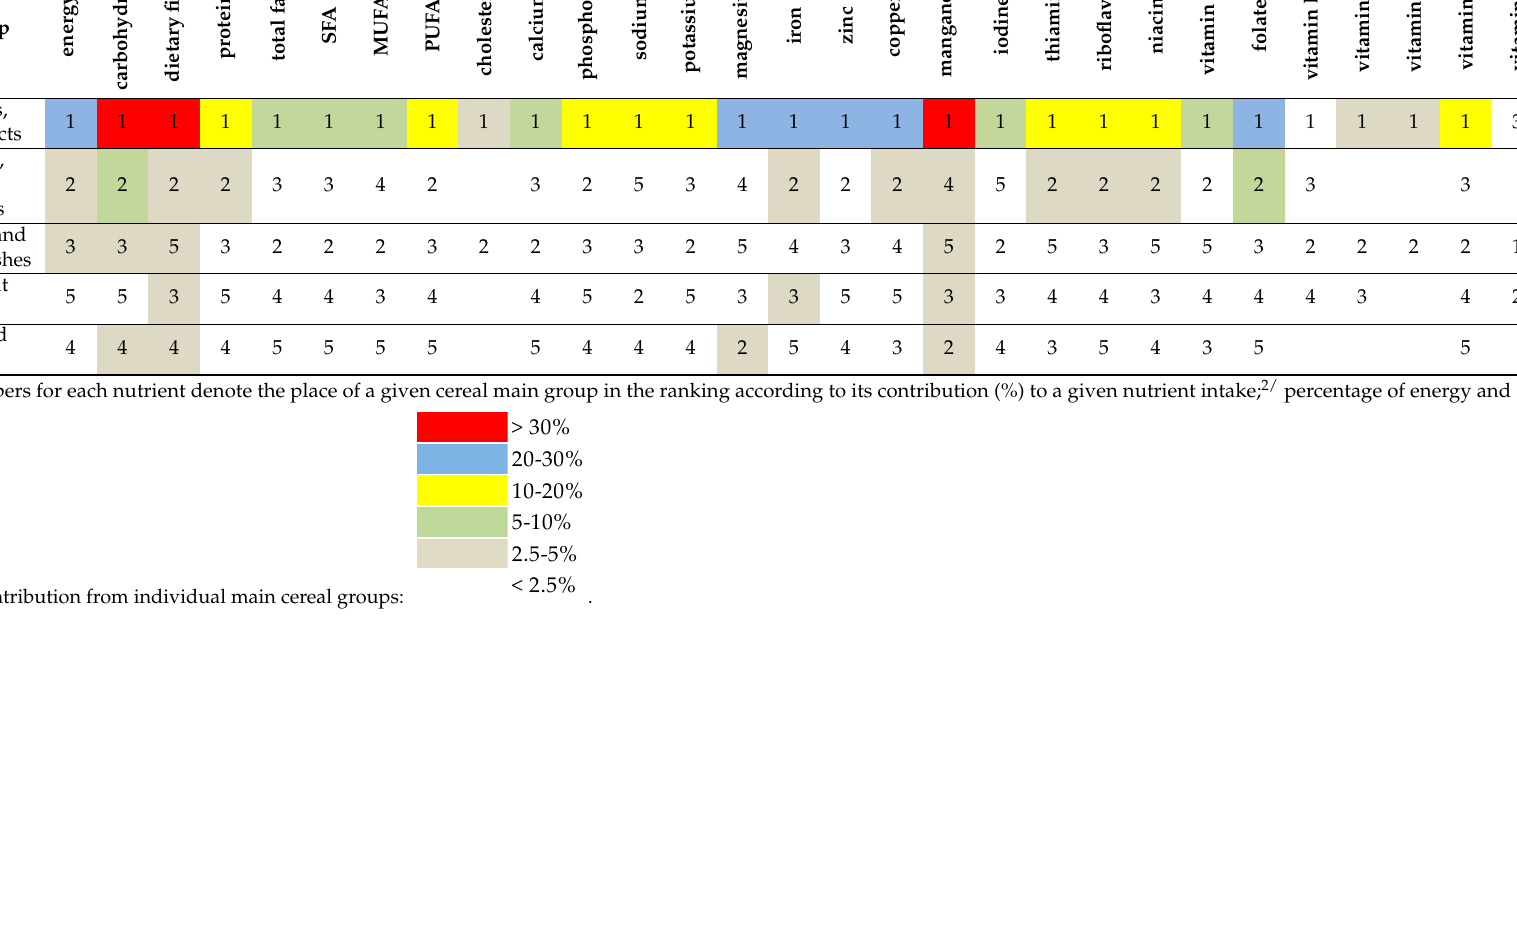
Table 7. Rankings 1/ of main cereal groups as contributors of energy and nutrients 2/ in the average Polish diet.